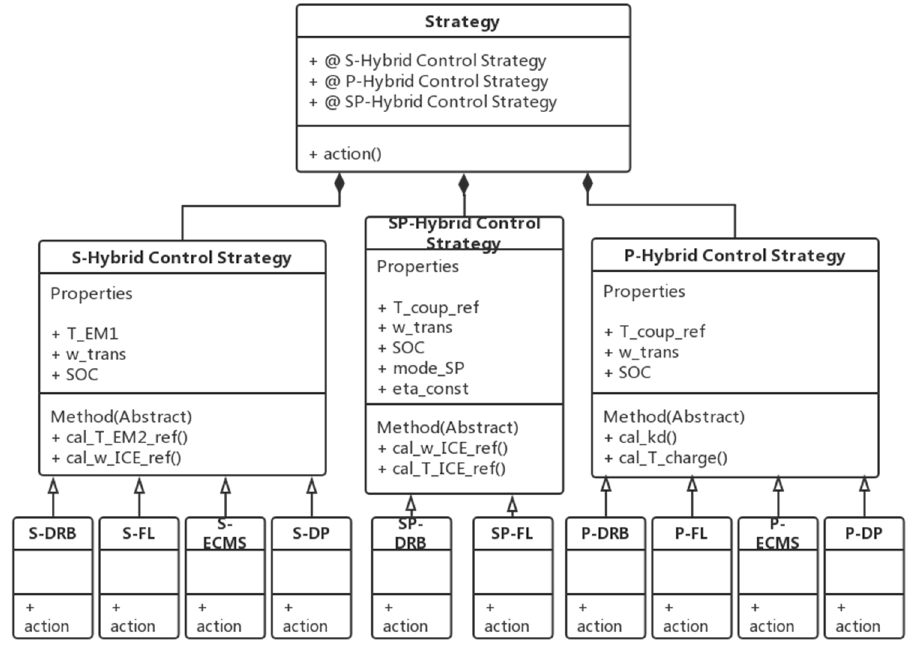
Figure 7. UML of CsT OOP model.